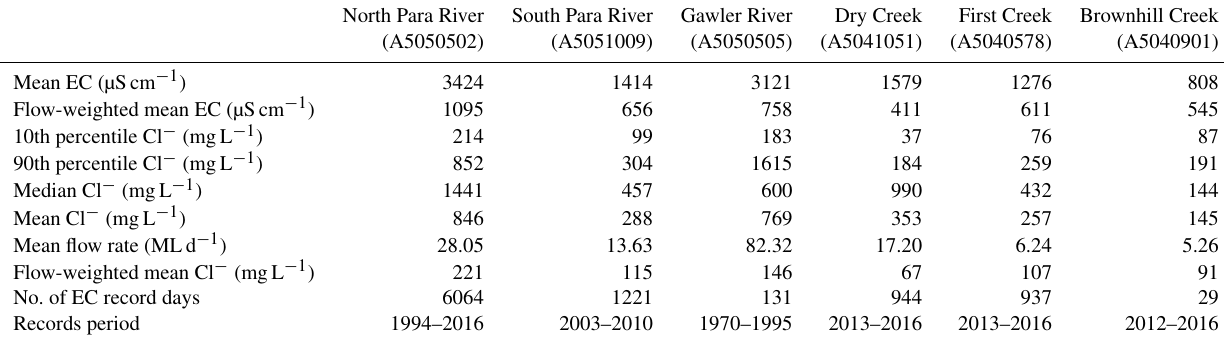
Table 1. Surface water flow rate, EC values and their conversion into Cl − concentrations for the six gauging stations located near the mountain-front zone (gauging station number in parenthesis; see Fig. 2 for site locations). Note that the North Para River and South Para River join about 1km downstream of the Para Fault to form the Gawler